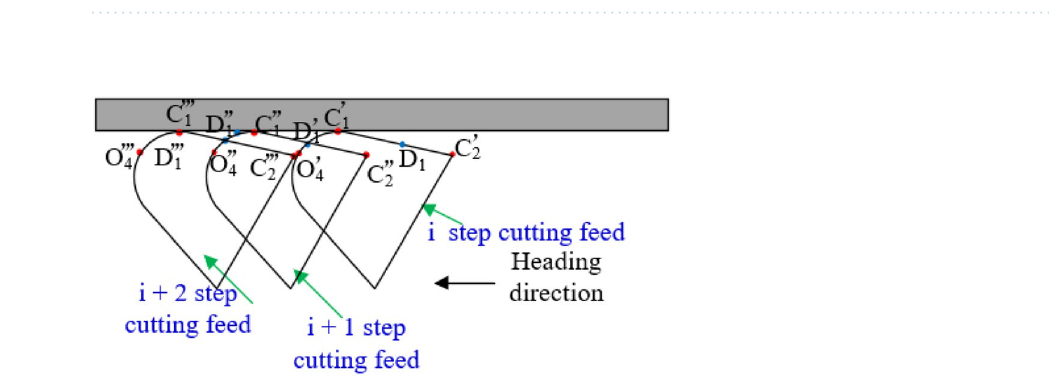
Table 1. Orthogonal test table.